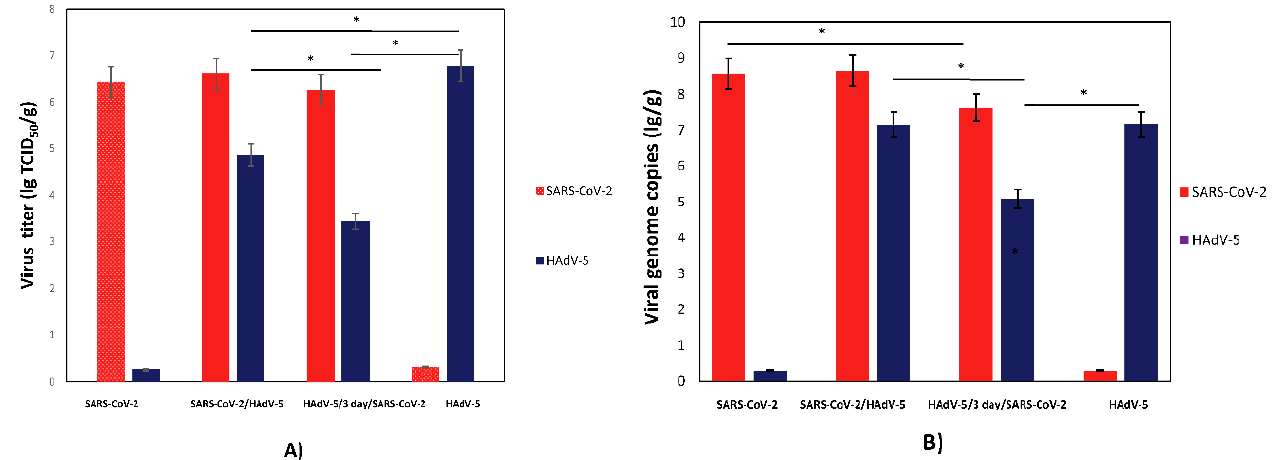
Figure 2. SARS-CoV-2 and HadV-5 replication in monoinfected and coinfected hamsters. ( A ) SARS-CoV-2 and HadV-5 viral infectious titers; ( B ) SARS-CoV-2 and HadV-5 viral genome loads. SARS-CoV-2 — Syrian hamsters were intranasally challenged with SARS-CoV-2 (10 5 TCID 50 ); SARS-CoV-2/HadV-5 — Syrian hamsters were simultaneously intranasally challenged with SARS-CoV-2 (10 5 TCID 50 ) and HadV-5 (10 6 TCID 50 ); HadV-5/3-days/SARS-CoV-2 — Syrian hamsters were intranasally challenged with HadV-5 (10 6 TCID 50 ) and, 3 days later, with SARS-CoV-2 (10 5 TCID 50 ); ad — Syrian hamsters were intranasally challenged with HadV-5 (10 6 TCID 50 ). On Day 3 postinfection (for the ad/3 days/CoV group, this took place on Day 3 after the challenge with SARS-CoV-2), half of the lung tissues collected from hamsters were homogenized to determine the viral infectious titers and RNA/DNA genome loads. (A) The SARS-CoV-2 and HadV-5 titers, expressed as the 50% tissue culture infectious doses per gram (TCID 50 /g), were determined by the CPE assay in Vero E6 (Table S2) and HEK293A (Table S3) cells, respectively. (B) The lung homogenates were analyzed for viral genome loads by dPCR. The SARS-CoV-2 and HadV-5 genome loads were determined using primers targeting the 1ab and hexon genes, respectively. The values represent the means ± SDs of three hamsters. Student’s t -test was used for two-group comparisons, * p < 0.05.